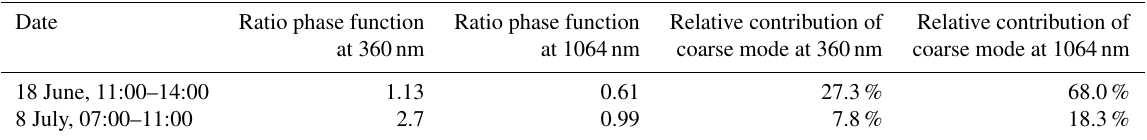
Table A28. Ratios of phase functions (coarse / fine) in exactly backward direction and the relative contribution of coarse mode to the backscat- tered signal at both